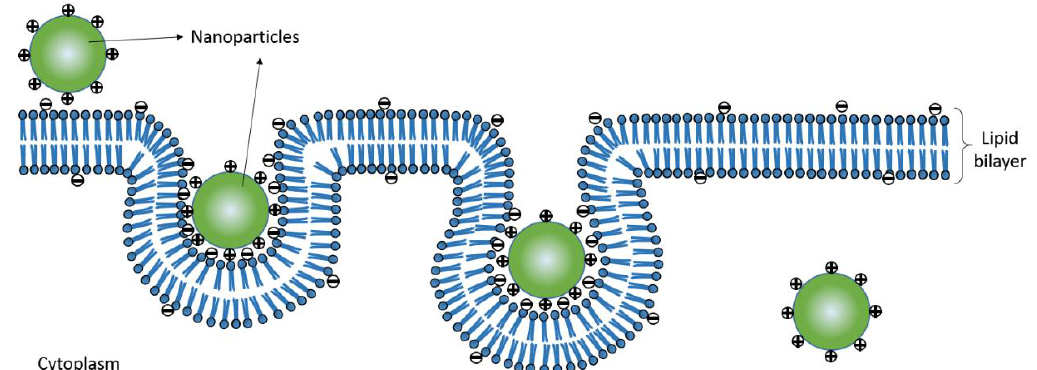
Figure 9. The cell uptake illustration of nanoparticles with surface positive charge.